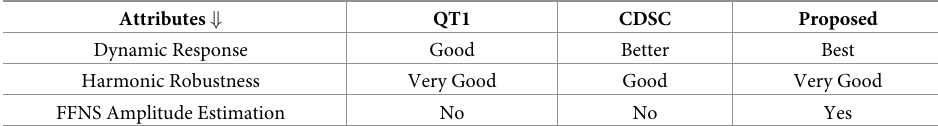
Table 3. Qualitative performance comparison of selected PLLs.